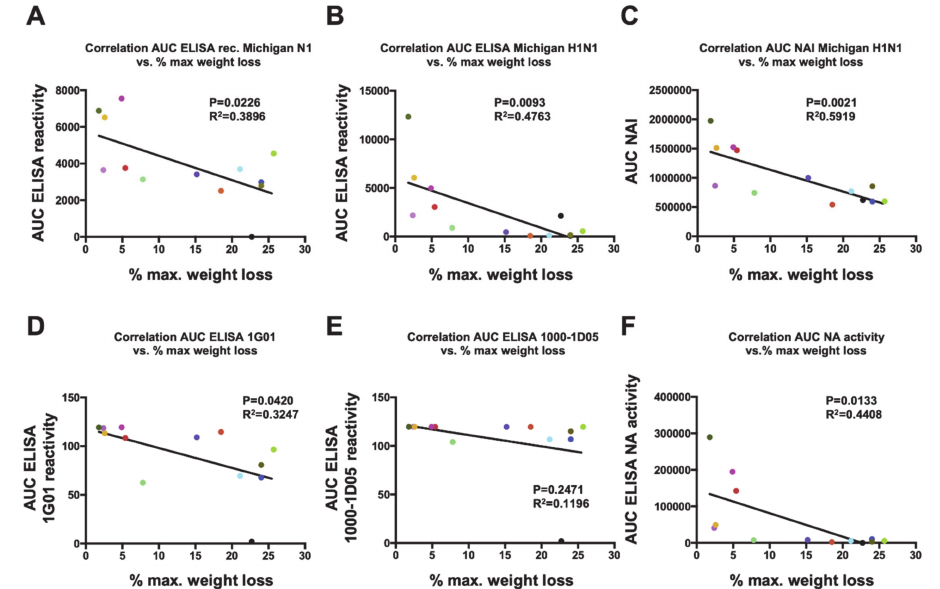
Figure 5. Correlations between weight loss and antibody responses. Correlation analyses of the maximum percentage of weight loss (MPWL) after vaccination with the different NA constructs and viral challenge (refer to Figure 3) were performed against different parameters. MPWL vs. area under the curve (AUC) obtained from an ELISA using the recombinant tetrameric Mich15-VASP protein ( A ) or purified A/Michigan/45/2015 virus ( B ). MPWL vs. the AUC obtained from an NI assay using purified A/Michigan/45/2015 ( C ). MPWL vs. ELISA binding of the broadly reactive NA monoclonal antibodies 1G01 ( D ) and 1000-1D05 ( E ) to the respective recombinant NAs. MPWL vs. the enzymatic activity of the respective NAs ( F ). The colors of the dots are consistent with groups in the preceding